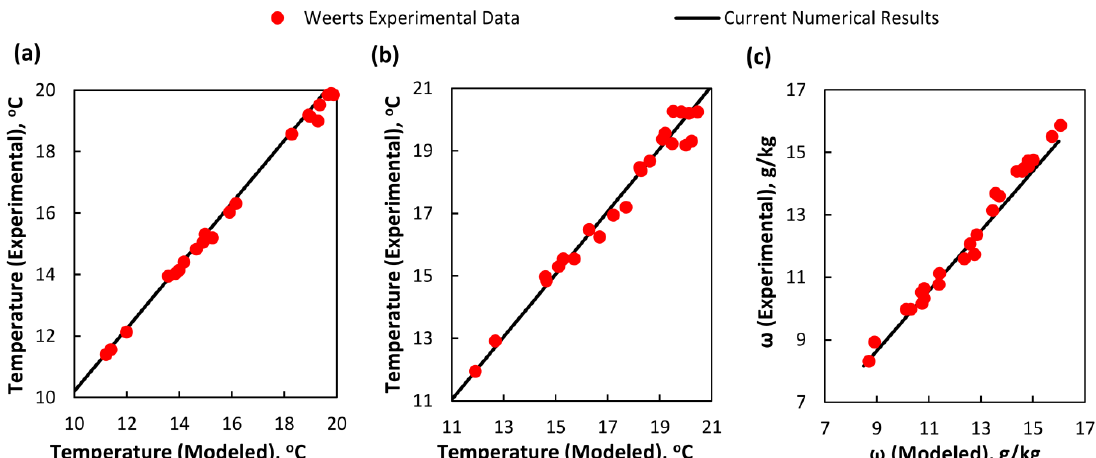
Figure 4. Correlation-based validation with Weerts’s data [22] for ( a ) product air outlet temperature; ( b ) working air outlet temperature; and ( c ) working air outlet absolute humidity.